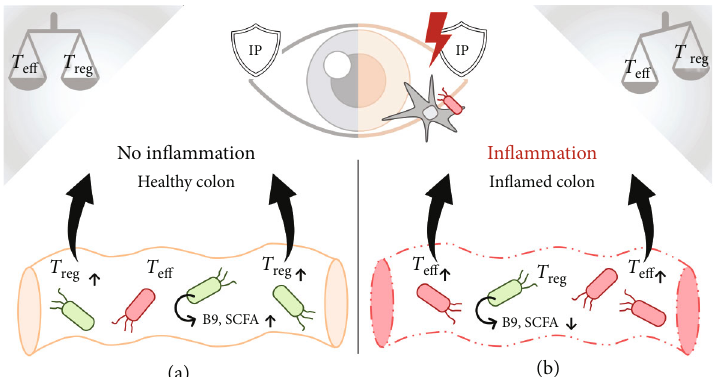
Figure 1: Bioavailable folate (B9) produced by certain phyla of the human microbiome ( Proteobacteria , Firmicutes , Actinobacteria , and ) in the colon, thereby Verrucomicrobia [84]; green microbes) and short-chain fatty acids (SCFA) locally stabilize T regulatory cells ( T reg increasing their abundance (a). T cells tra ffi c from the colon to distant sites [85, 86] where they accumulate and exert their respective functional properties. The in fl amed colon ((b); characterized by structural damage —“ leaky gut ” ) is frequently accompanied by dysbiosis (red microbes). This qualitative and quantitative shift in bacterial colonization is associated with decreased microbial folate and SCFA production and a consequential relative increase in autoreactive immunogenic T e ff ector cells ( T ) [87]. T have been shown to tra ffi c eff eff from the colon to target sites of autoimmunity [85, 86] (e.g., intraocular tissue in the case of autoimmune uveitis), skewing the ratio of immunogenic ( T ) to regulatory cells ( T ) at target sites [88 – 90], ultimately breaching ocular immune privilege (IP) through unknown eff reg